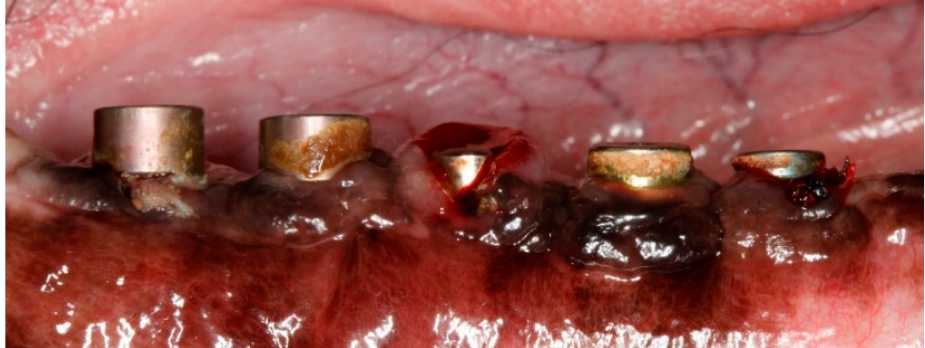
Figure 4. Post-operative image at 9-month post-implantation. Note the ligatures placed in alternating implants 1, 3 and 5, and the subsequent local inflammation.